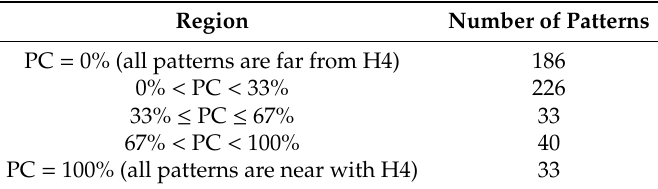
Table 4. Connection between patterns and histidine